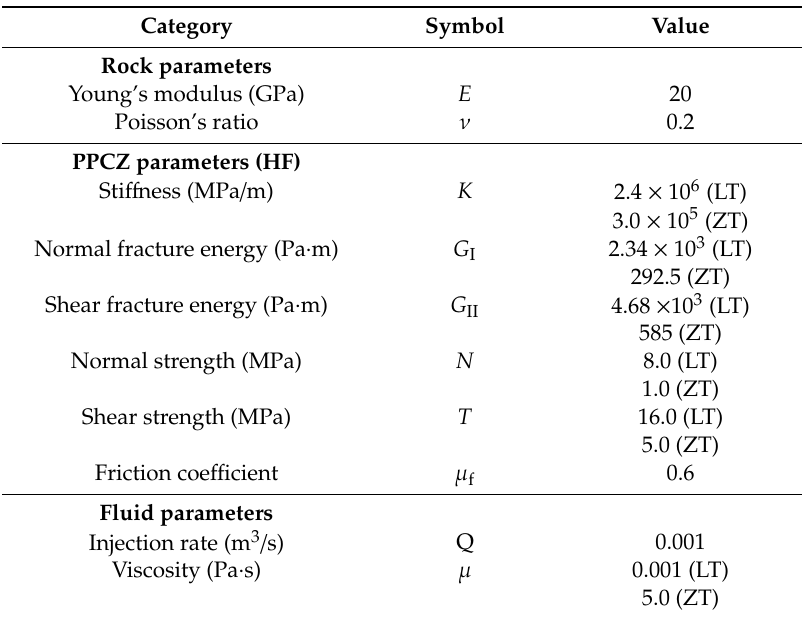
Table 1. Input parameters of the KGD